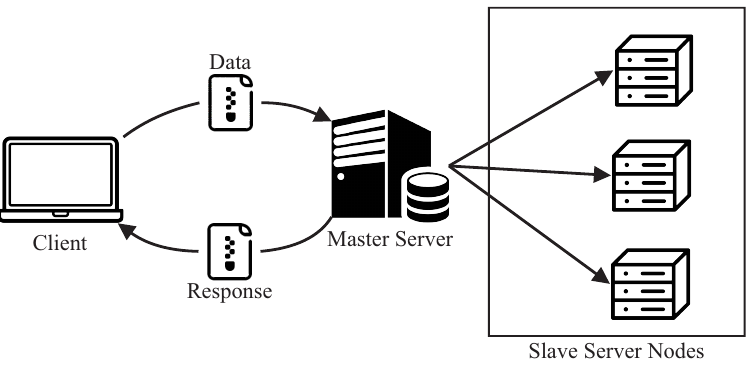
Figure 11. Validation Test-Bed Architecture (adapted from